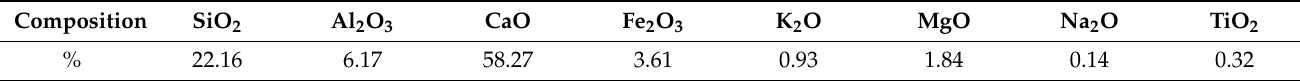
Table 2. Composition of cement.